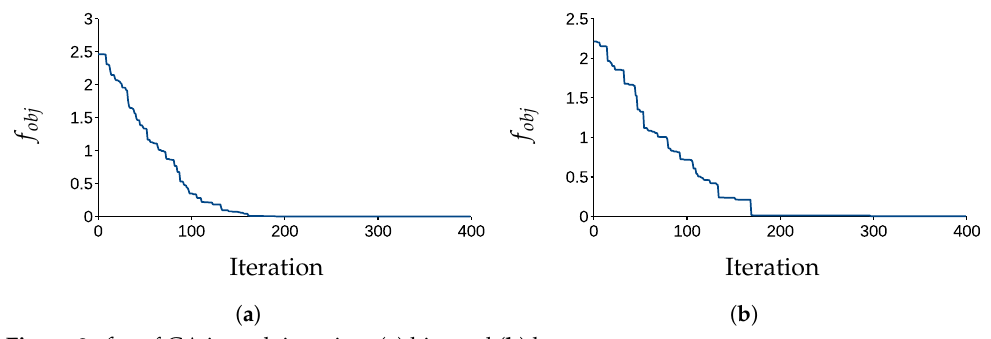
Figure 2. f obj of GA in each iteration. ( a ) hip; and ( b )